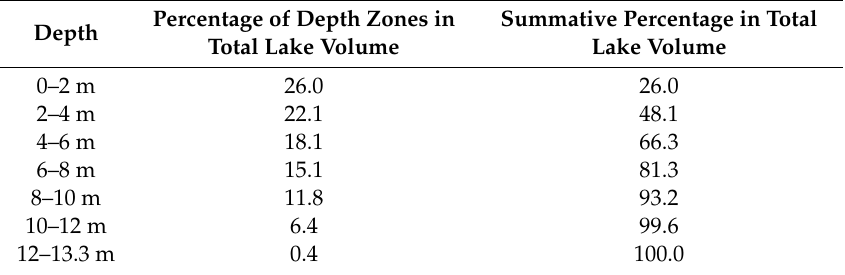
Figure 6. Bathygraphic curve of Lake Borówno (prepared on the basis of bathymetric measurements conducted in 2018). Table 7. Morphometric data of Lake Borówno (prepared on the basis of bathymetric measurements conducted in 2018).